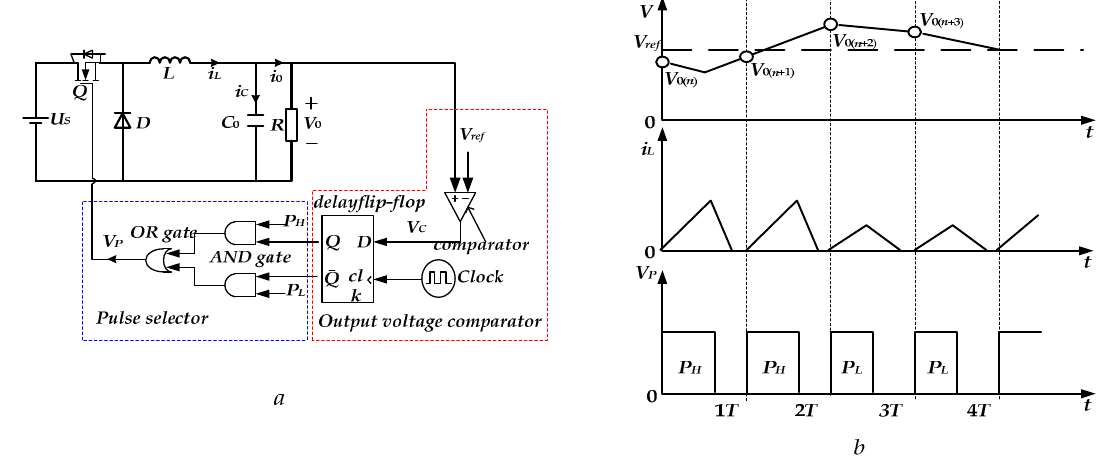
Figure 4. The principle of PT and CC-PT control. ( a )VM-PT controlled Buck converter schematic; ( b ) schematic of working principle.